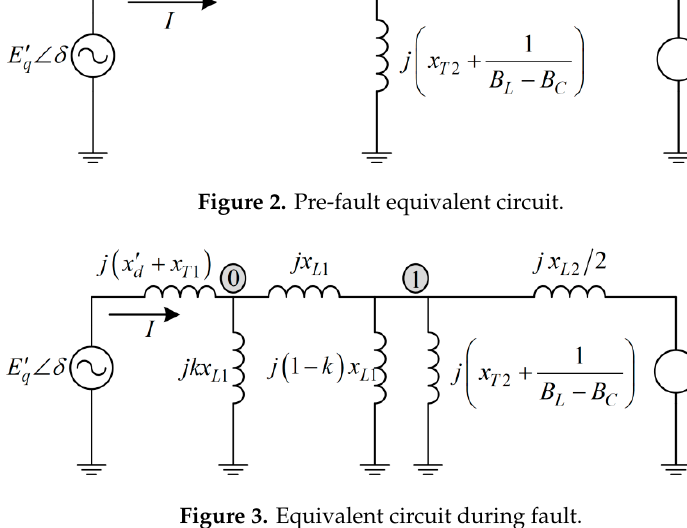
Figure 3. Equivalent circuit during fault.